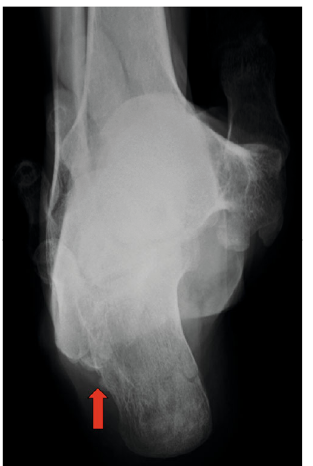
Figure 6: The patient ’ s right foot one year after the procedure: the relapse of resected hypertrophic peroneal tubercle could not be